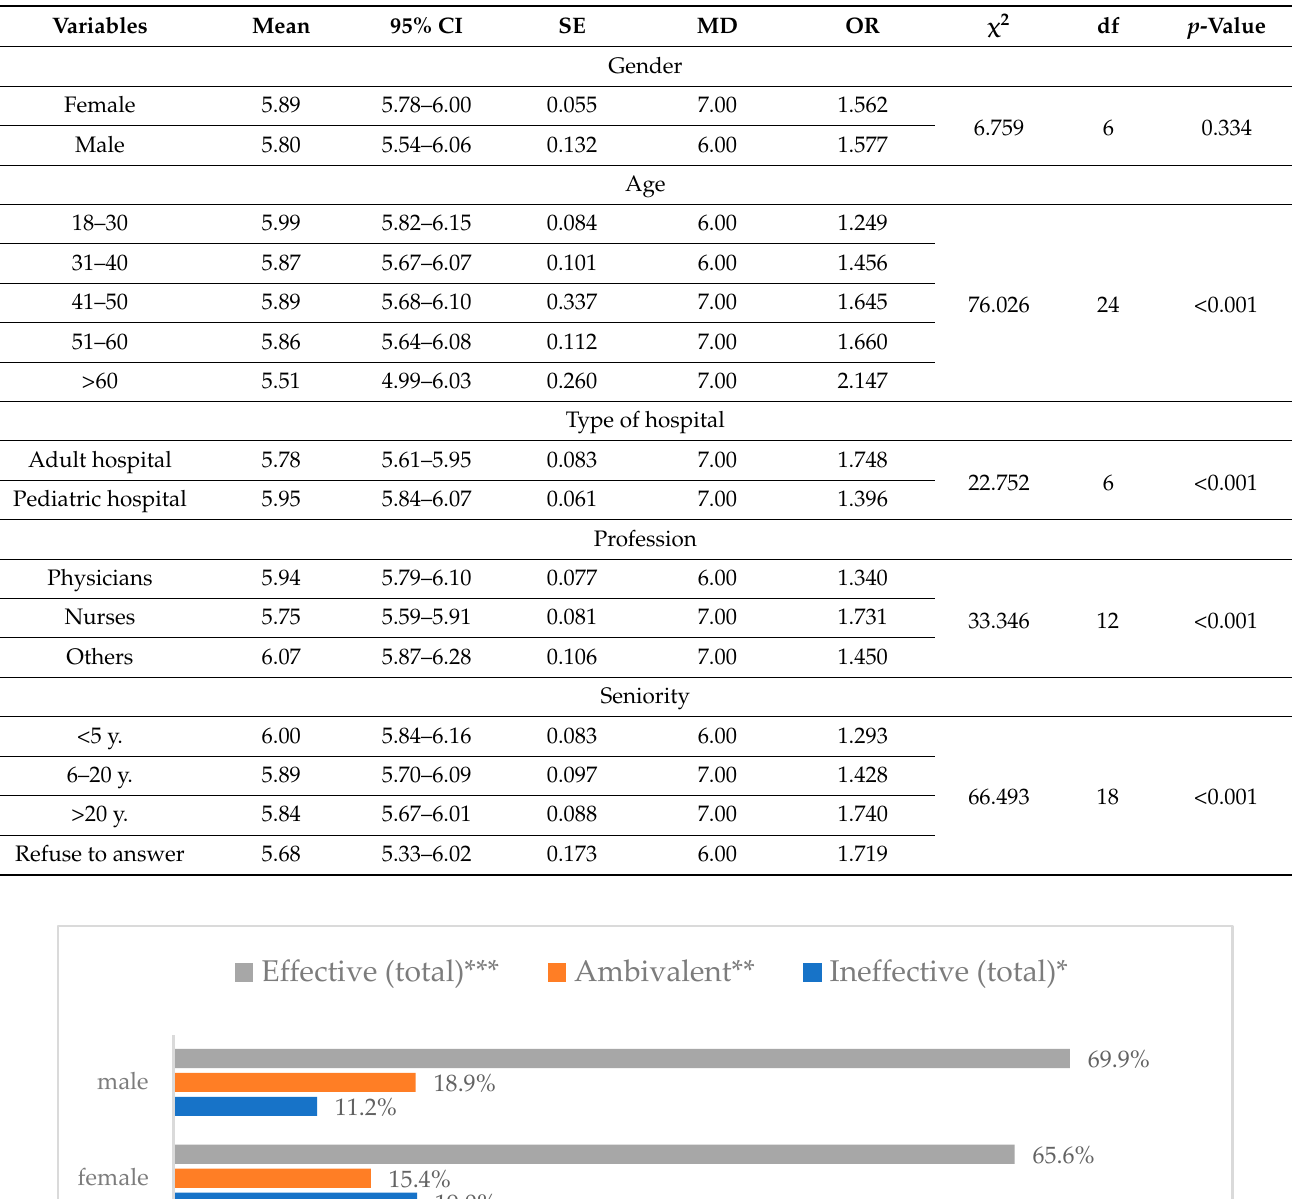
Table 4. Evaluation of handwashing as a means of preventing influenza virus infection by sociode- mographic category ( N = 950).